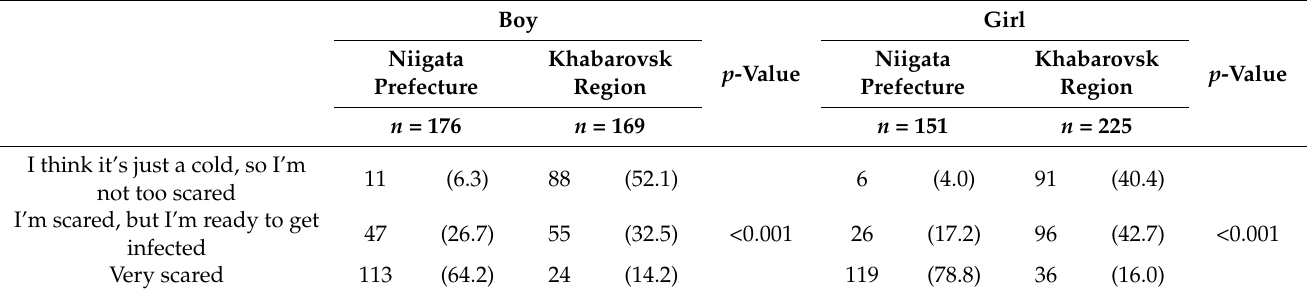
Table 5. “Are you afraid to get infected with COVID-19?”.